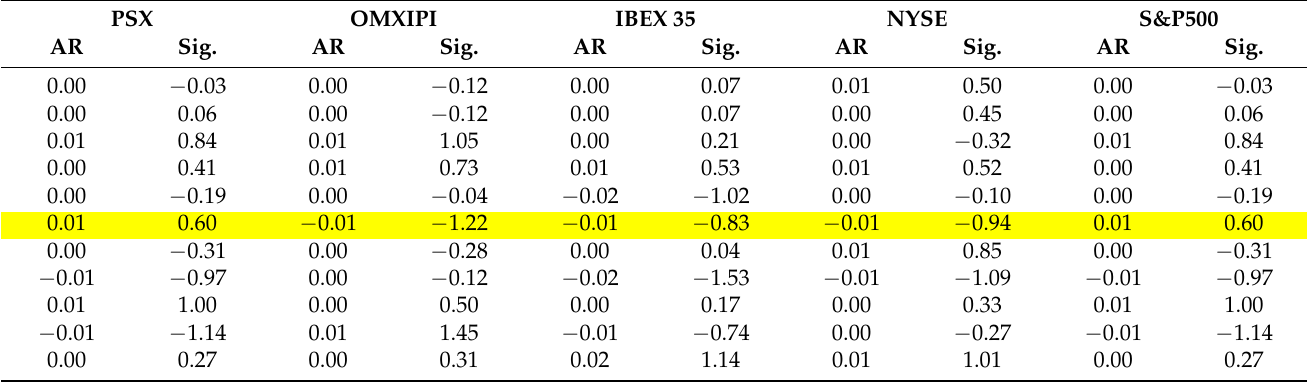
Table A3. Abnormal returns for the ( − 5, +5) event window (News of Panama leaks).